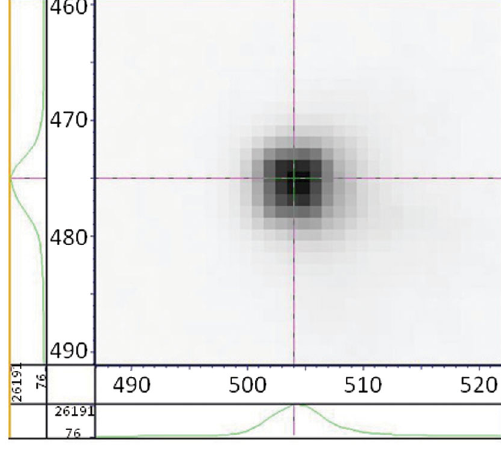
FIG. 7. Response of a single DMD pixel to uniform white light illumination.